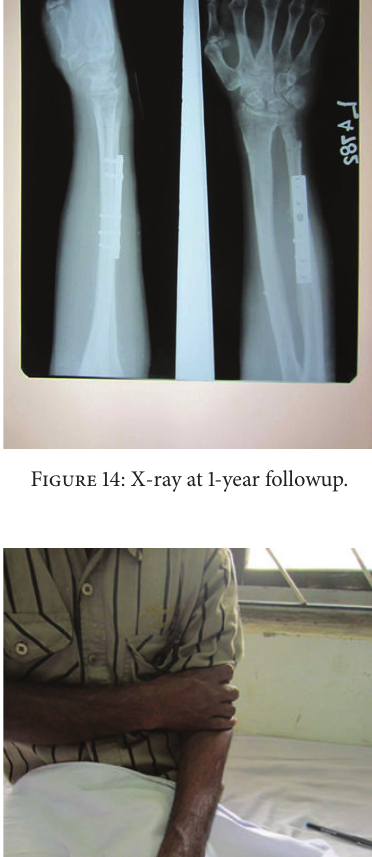
thereby allowing near normal range of motion including pronation-supination. ECU tenodesis was used only to aug- ment the palmaris longus tenodesis and not to stabilise the